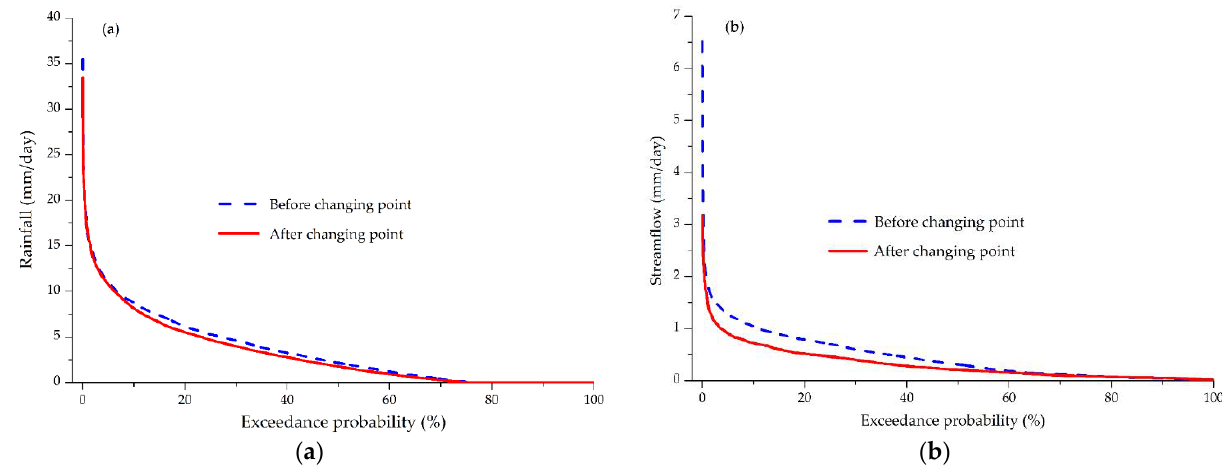
Figure 10. Exceedance probability curve of the Bilate watershed: ( a ) rainfall for the period 1986–1997 (before changing point) and 1998–2015 (after changing point), and ( b ) streamflow for the period 1986–2007 (before changing point) and 2008–2015 (after changing point). Table 2. Rainfall and streamflow exceedance probability of the Bilate watershed.